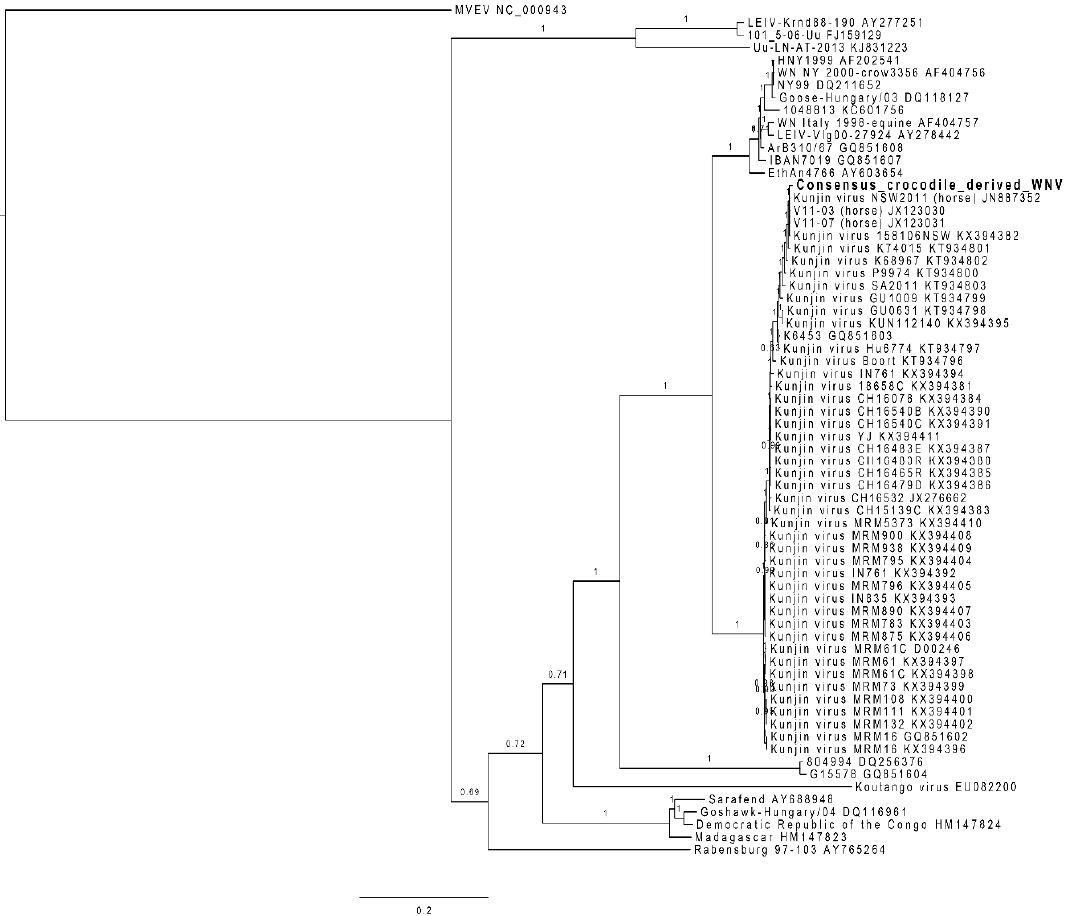
Figure 2. Phylogeny of the C. porosus -derived WNV strain (Genbank accession number: MN954648). This maximum likelihood phylogeny was built from a nucleotide alignement of the whole genome of 67 WNV sequences and one Murray Valley Encephalitis virus (NC_000943) sequence used as an outgroup, using MrBayes 3.2.6 in Geneious 8.1.9. The branch labels represent the posterior probability and the scale bar represents the substitutions per site.